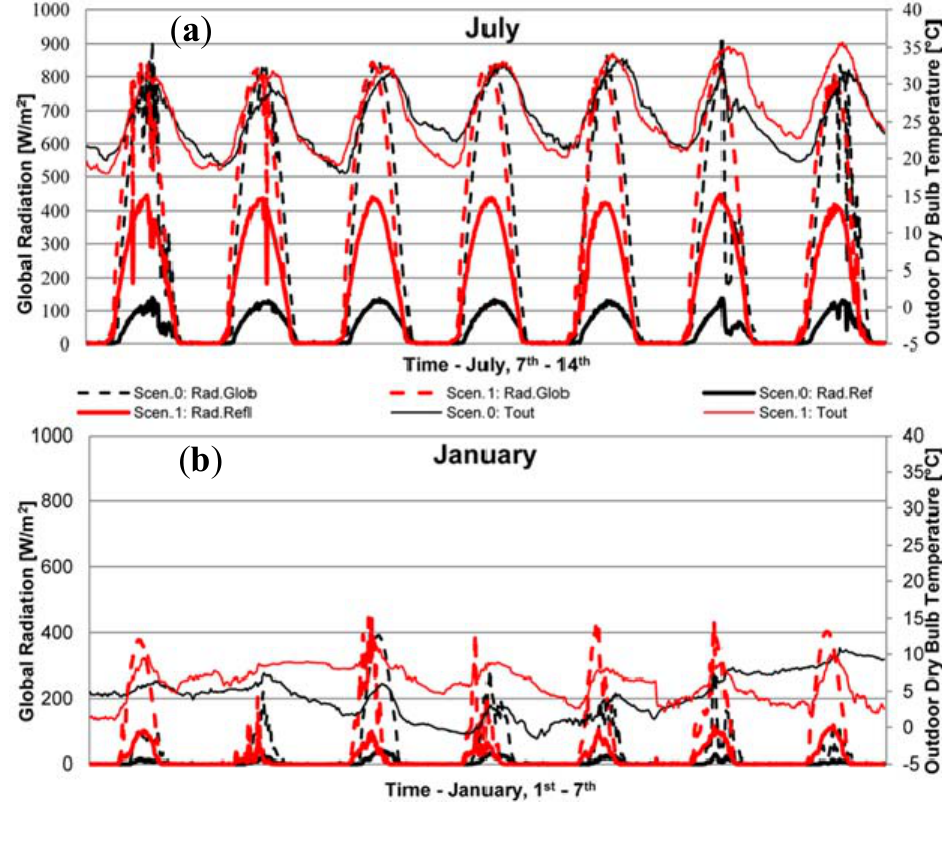
Figure 4. Global reflected radiation capability with respect to the outdoor temperature in ( a ) July and ( b )